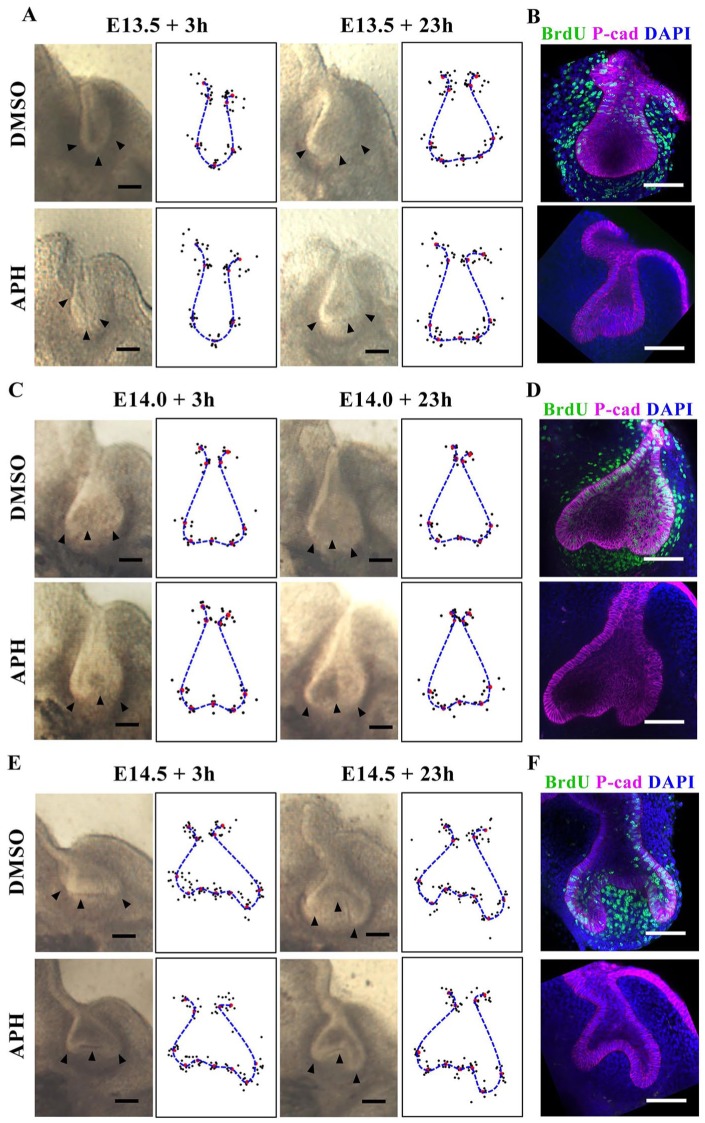
Proliferation inhibition does not inhibit tooth explant bud-to-cap morphogenesis. (A, C, E) Typical brightfield images of tooth explants with or without aphidicolin (APH) at the times indicated with corresponding epithelial landmark and contour plots for multiple samples (n = 10 explants from 3 litters for E13.5 and E14.5, n = 6 explants from 1 litter for E14.0). Small black dots show positions of individual landmarks; red dots show average position of each landmark; and blue dashed line indicates average contour. (B, D, F) Confocal images of explants shown in panels A, C, and E were labeled for a further 2 h with BrdU (green), confirming that proliferation was inhibited by APH. Buccal is left in all panels. Scale bar = 100 μm.